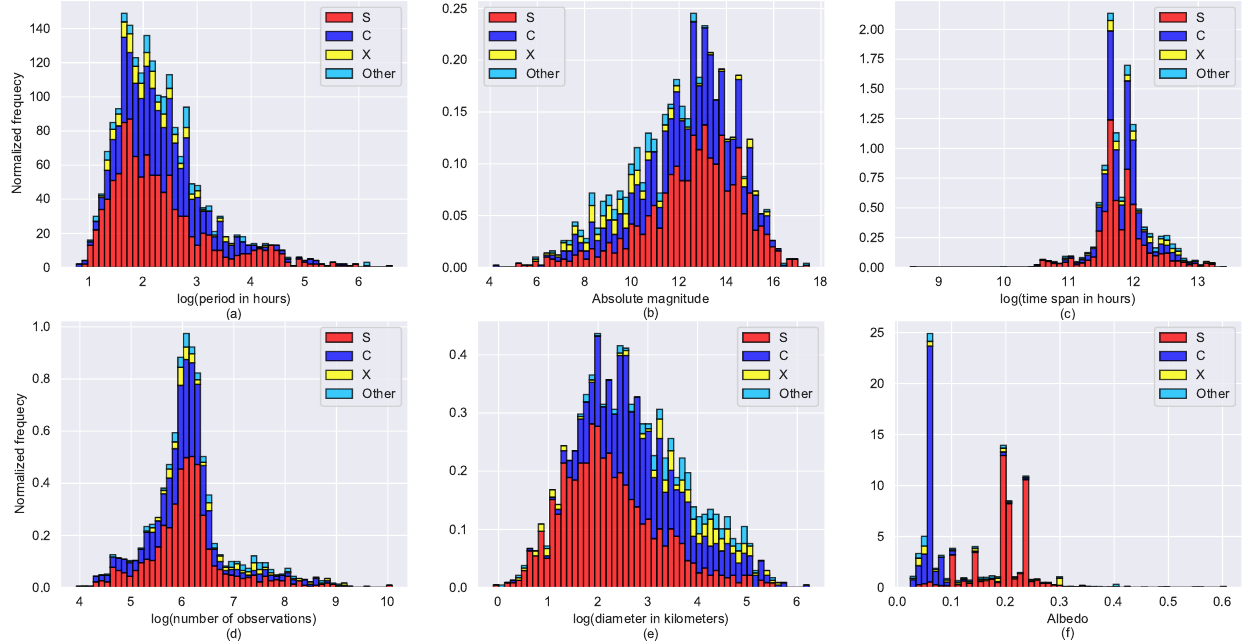
Figure 3. The distribution of ( a ) reported periods in hours, ( b ) absolute magnitudes, ( c ) time spans in hours, ( d ) number of points in each light curve, ( e ) diameters in kilometers and ( f ) albedos for asteroids of different classes in DAMIT. The “normalization” in the ordinate means: the integral of the probability density is 1, that is, its total area (the sum of the products of the horizontal and vertical coordinates of each bar chart) is 1. The letters in the legend indicate the codes of different types of asteroids classified by spectrum, which are mainly divided into S, C, X and Other types. Among them, S-type asteroids are stony meteorite asteroids, which account for 17% of all asteroids, and are the second most numerous asteroids, generally composed of silicides; C-type asteroids are carbonaceous chondrites. It accounts for 75% of all asteroids and is the most numerous asteroids, mostly distributed in the outer layer of the asteroid belt; X-type asteroids have very similar spectra, but there are still groups of different compositions (E-type, P-type, and P-type). In addition, other types of asteroids are relatively small, so they are unified into other types. In our data set, S-type asteroids account for a relatively high proportion of about 51.8%, while C-type asteroids account for about 36.5%, and X-type asteroids account for about